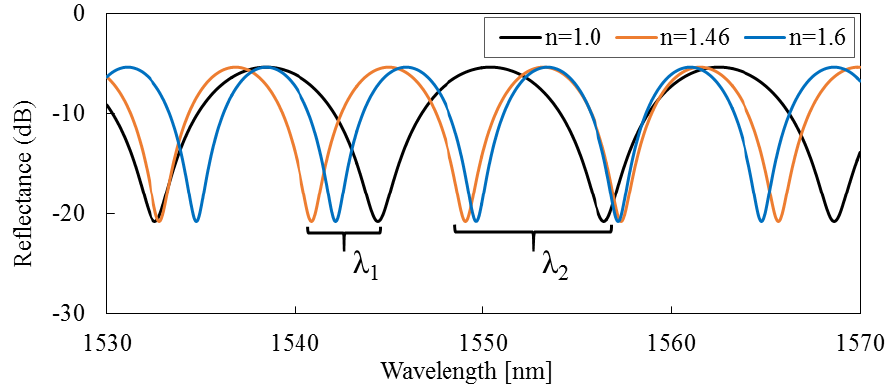
Figure 2. Reflection spectra calculated for RI of n = 1.0 (less than RI of silica), n = 1.46 (approximately equal to RI of silica), and n = 1.6 (greater than RI of silica), respectively.